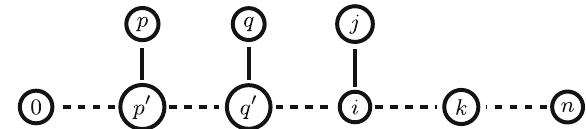
Figure 19: Minimum subgraph of C containing vertices